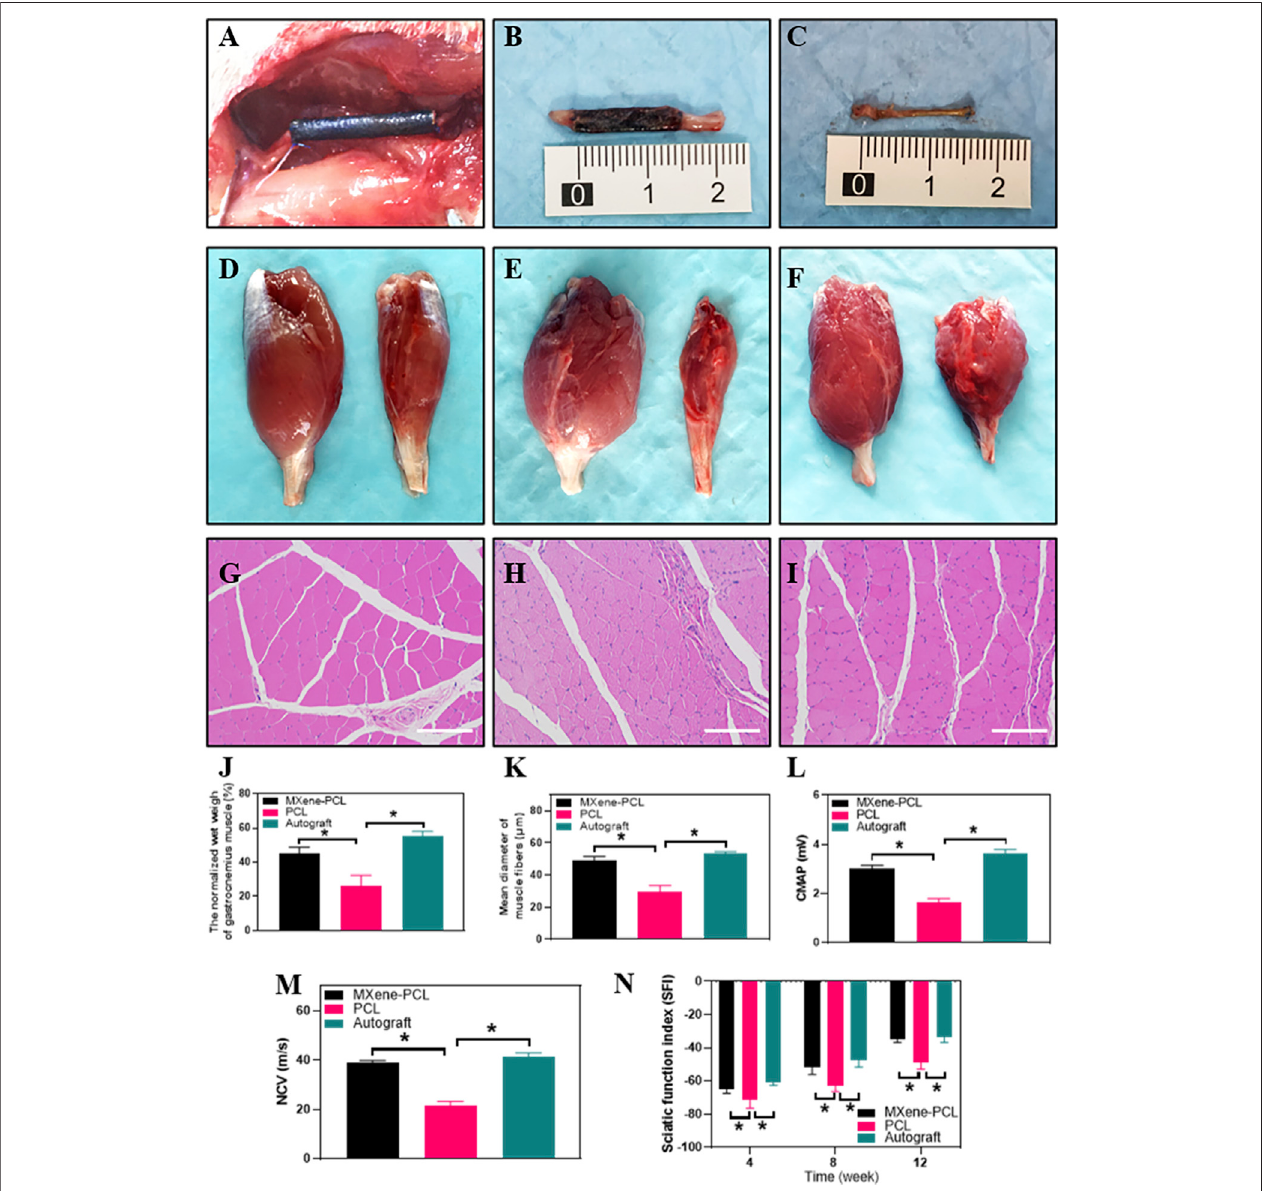
FIGURE 6 | Morphology of the MXene-PCL NGC and regenerated nerve, muscle reinnervation, SFI, and electrophysiological assessment. Morphology of MXene- PCL NGC at the time of implantation (A) , at 12 weeks after implantation (B) and the regenerated nerves obtained from Mxene-PCL NGC group (C) . Representative optical (D – F) and HE staining pictures of gastrocnemius muscle at 12 weeks postoperatively (G – I) . The normalized wet weight of gastrocnemius muscle (J) , Mean diameter of muscle fi bers (K) , compound motor action potential (L) , and nerve conduction velocity at 12 weeks after implantation. The sciatic functional index assessmentat4,8and12 weeksafterimplantation.MXene-PCLgroup (A – D) ,and (G) ;PCLgroup (E,H) ;Autograftgroup (F,I) .Experimentswererepeatedthreetimes. * p < .05. The scale bars are 200 μ